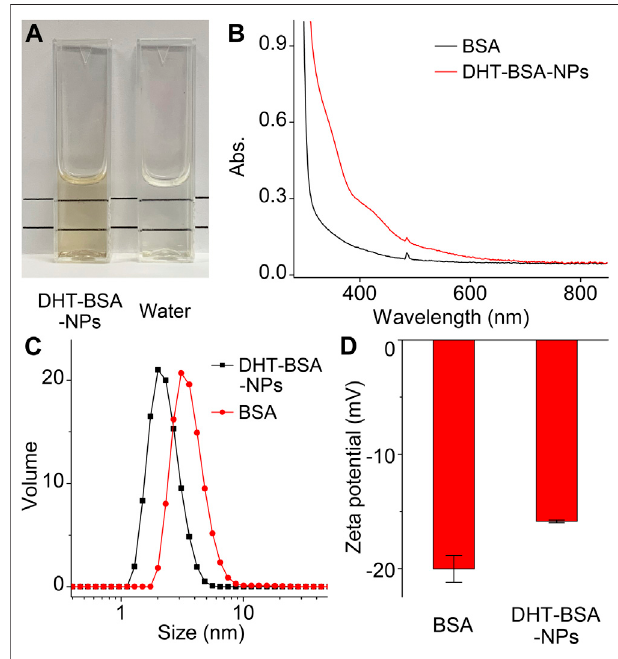
FIGURE 1 | Characterization of DHT – BSA NPs. (A) The solubility characterization of DHT – BSA NPs. (B) The absorbance characterization of DHT – BSA NPs and BSA. (C) The hydrodynamic size characterization of DHT – BSA NPs and BSA. (D) The zeta potential characterization of DHT – BSA NPs and